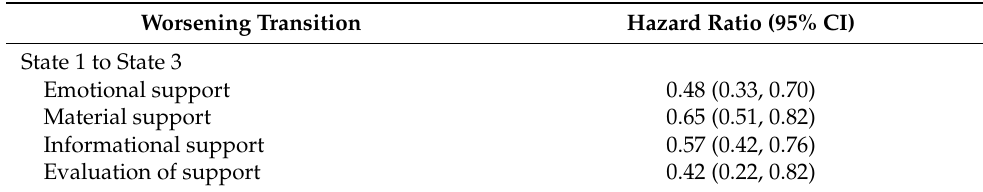
Table 5. The effects of covariates on PPD worsening